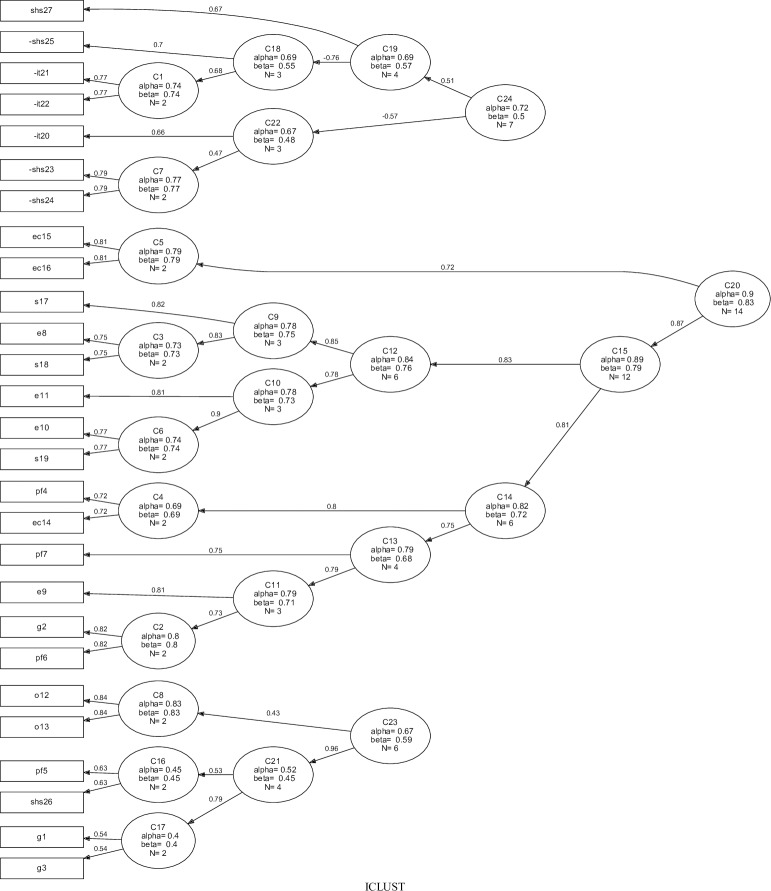
Questionnaire item clustering (n = 100).Clusters were formed using the ICLUST algorithm, and three higher-order clusters were identified: C23 = Bad theoretical meaning; C24 = Satisfaction with health services and treatment; C20 = Social, economic, functional and emotional impacts of the disease.